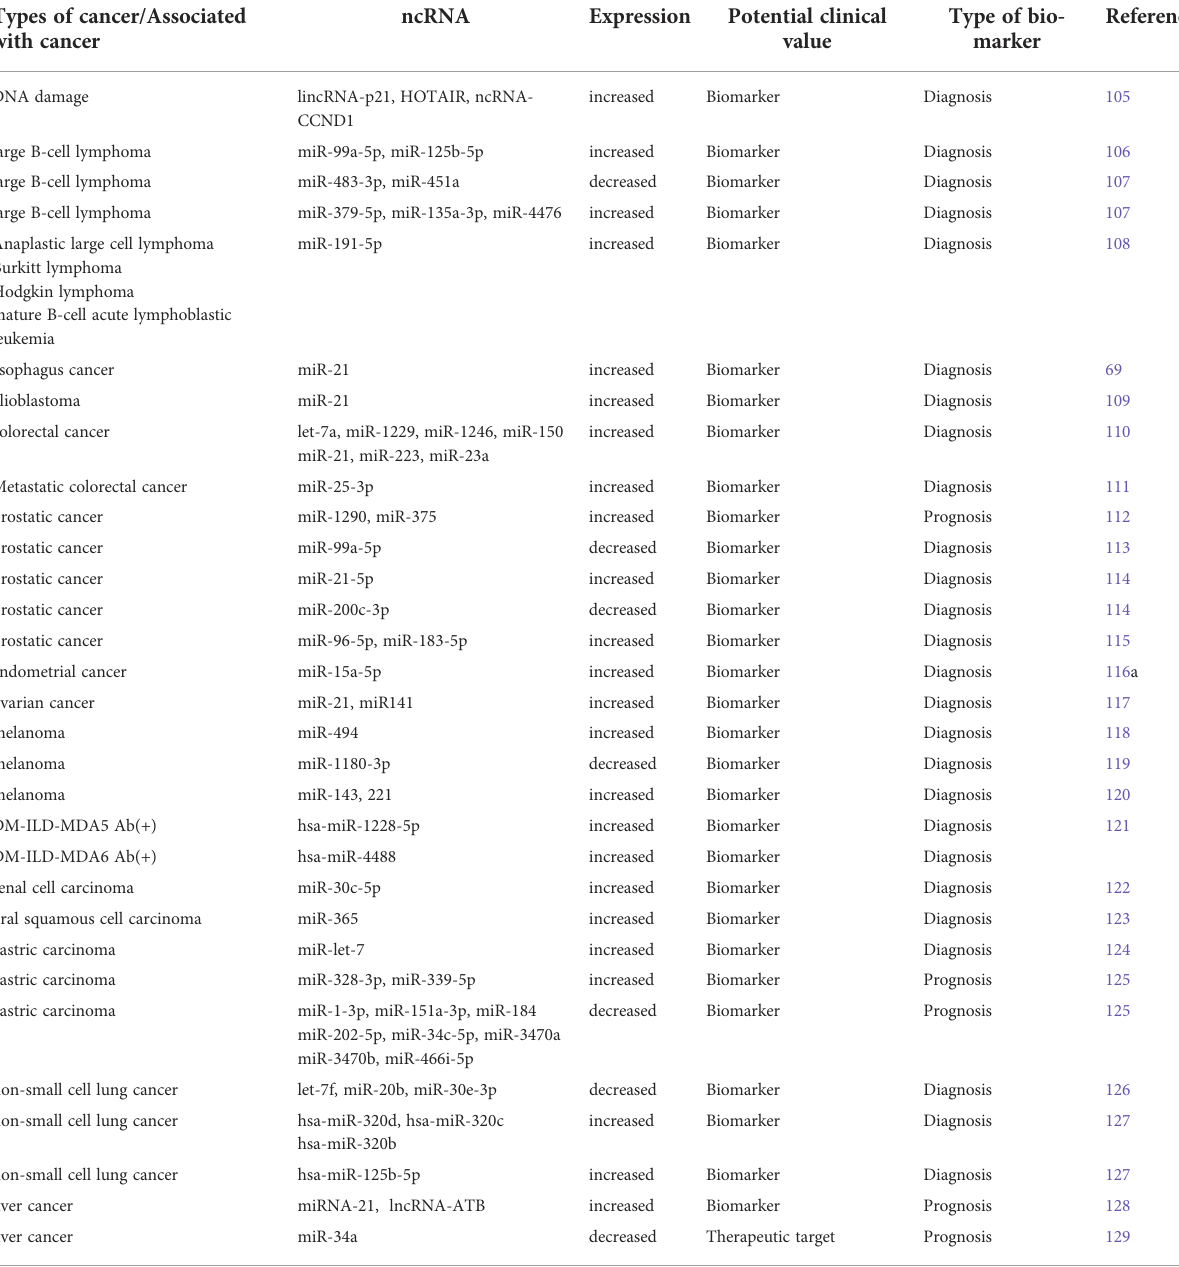
TABLE 2 Detailed information on exosomal ncRNAs as biomarkers. Types of cancer/Associated with